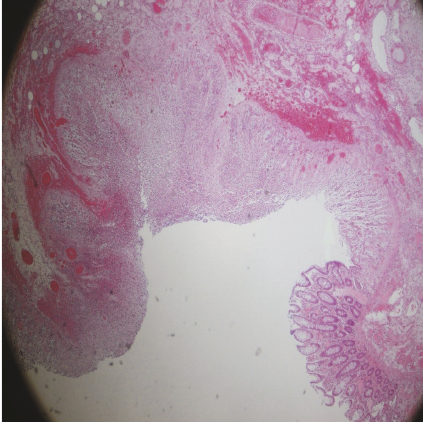
Figure1:Mucosalulcerwithnoatypicalcellsandcrystalssuggestive ulcer, inflammation, and gastrointestinal bleed (400x).